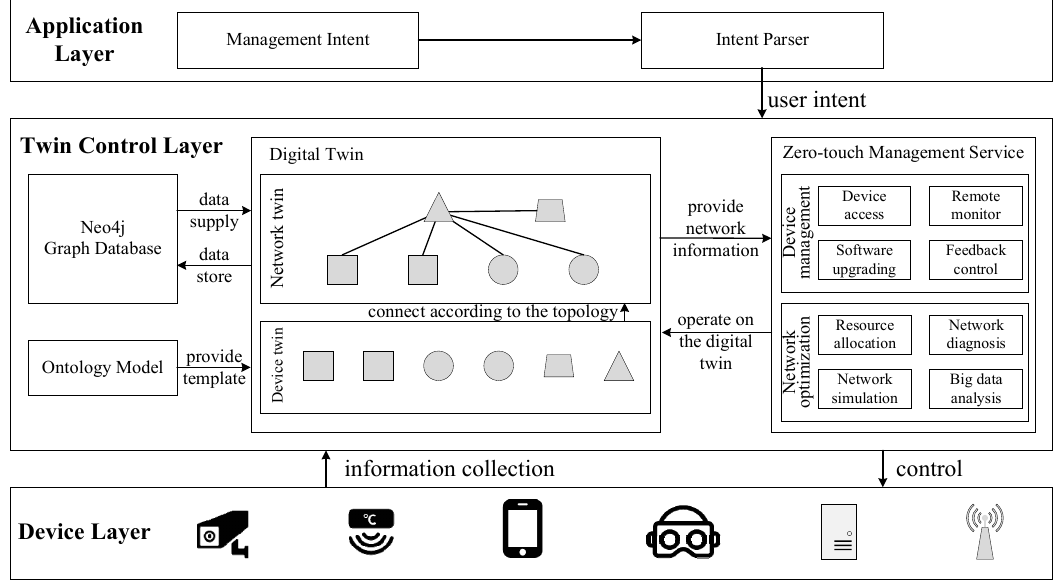
Figure 7. DT-based zero-touch management architecture for